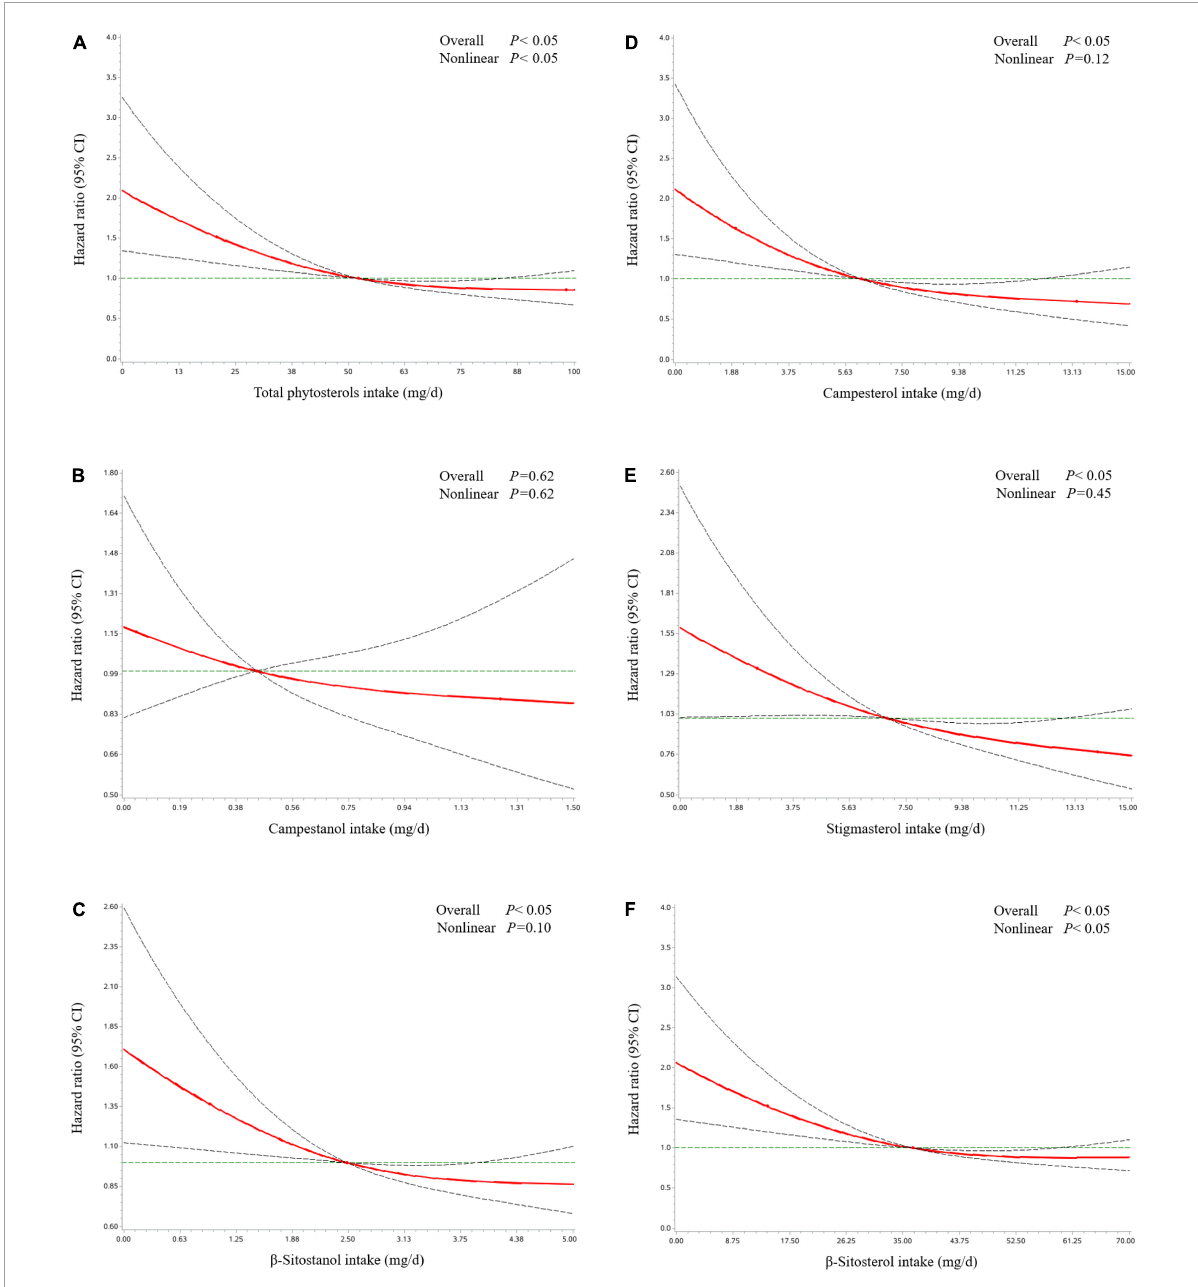
FIGURE3 Hazard ratio and 95% confidence interval of overall survival among ovarian cancer patients by total phytosterols (A) , campestanol (B) , β -sitostanol (C) , campesterol (D) , stigmasterol (E) , and β -sitosterol (F) . The associations were adjusted for age at diagnosis, education, cigarette smoking, alcohol drinking, monthly household income, dietary change, menopausal status, parity, body mass index, physical activity, federation of gynecology and obstetrics stage, histological type, histopathologic grade, residual lesions, comorbidities, and total energy, isoflavone, and monounsaturated fatty acid intake. The red line and dashed line represent the estimated HRs and their 95% CIs, respectively. CI, confidence interval; HR, hazard ratio; OC, ovarian cancer.